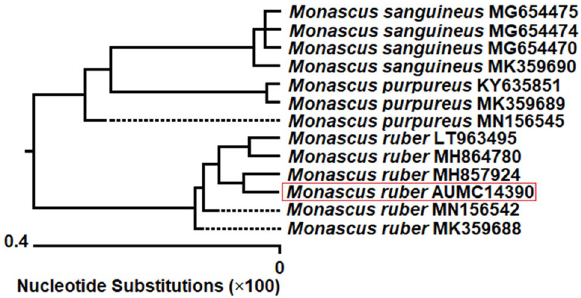
Figure 2. Phylogenetic tree of the pigment-producing fungal strain (AUMC14390) and other closely related strains of Monascus , based on the ITS1-5.8S rRNA-ITS2 rDNA sequences.